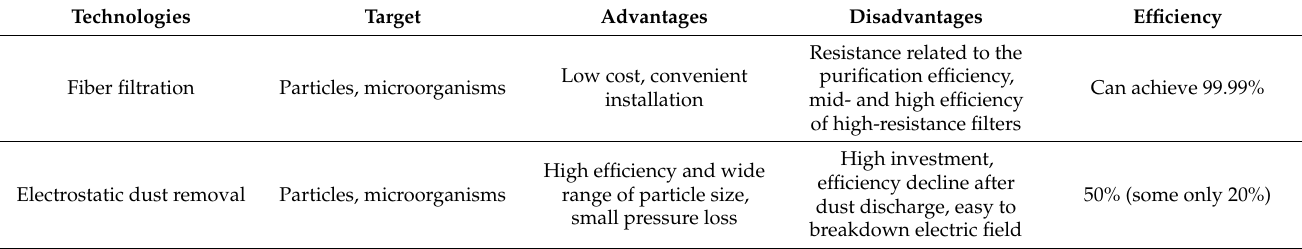
Table 1. Comparison of different purification and filtration technologies in building environments